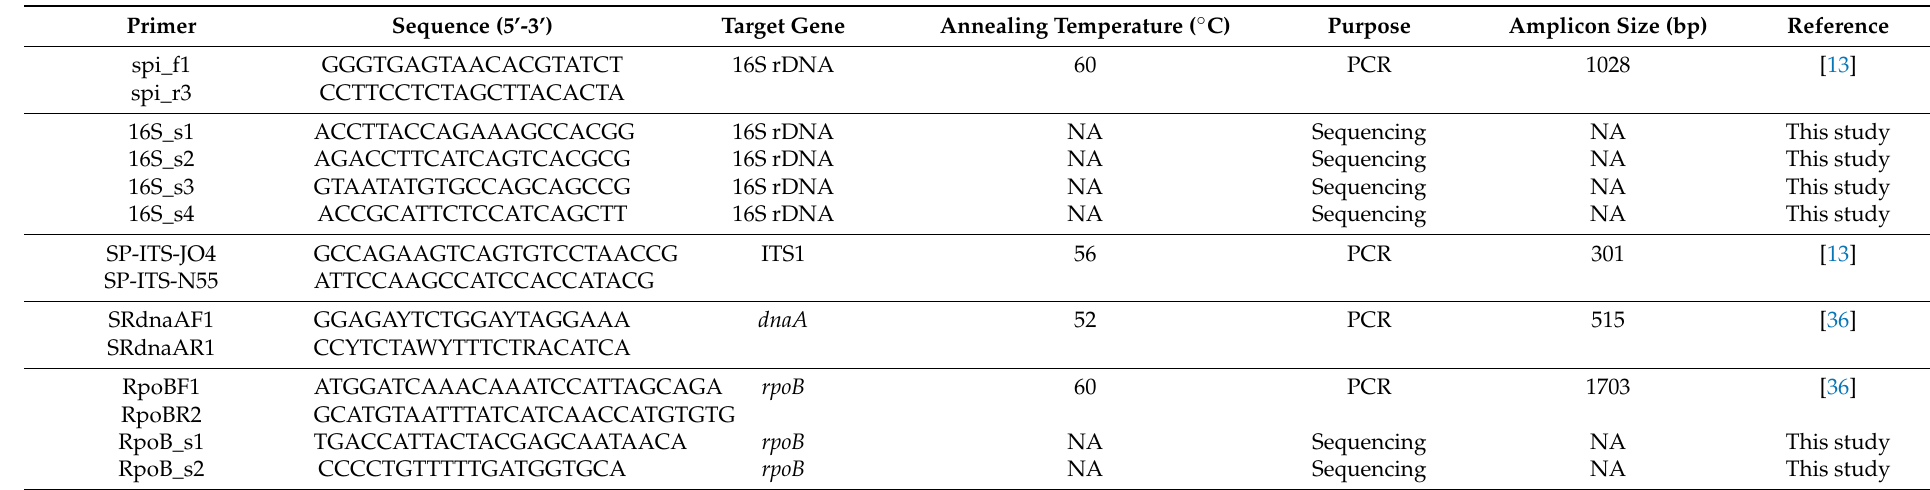
Table 1. Primers used in the present